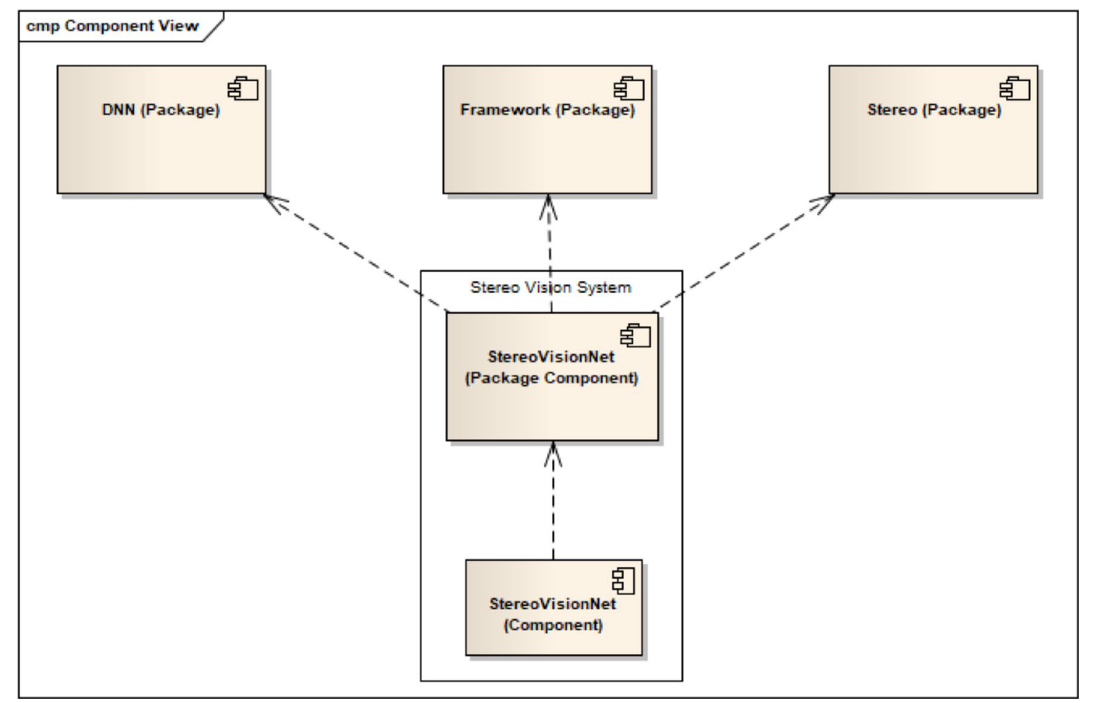
Fig. 10 Component diagram of the stereo vision